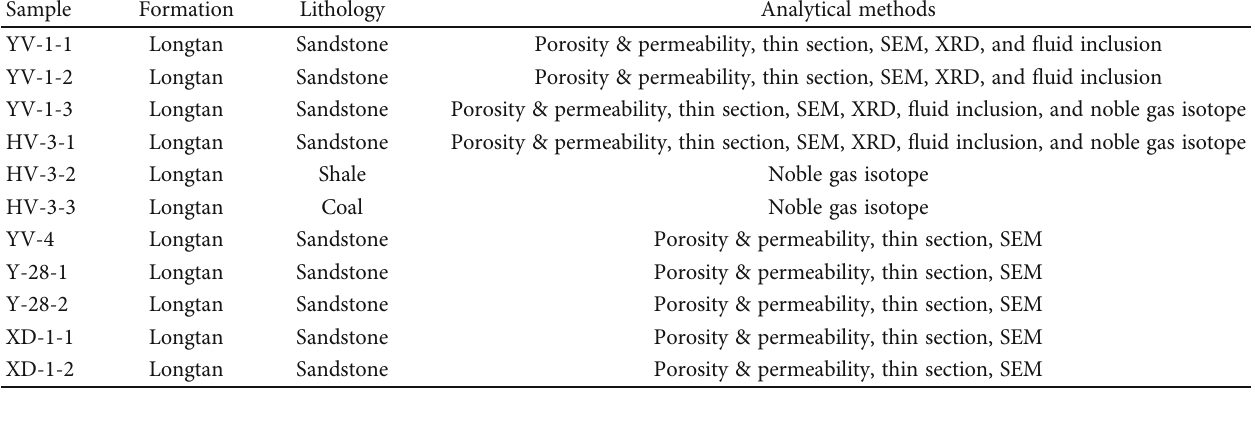
Table 1: Summary of the analytical methods employed for the 11 samples.